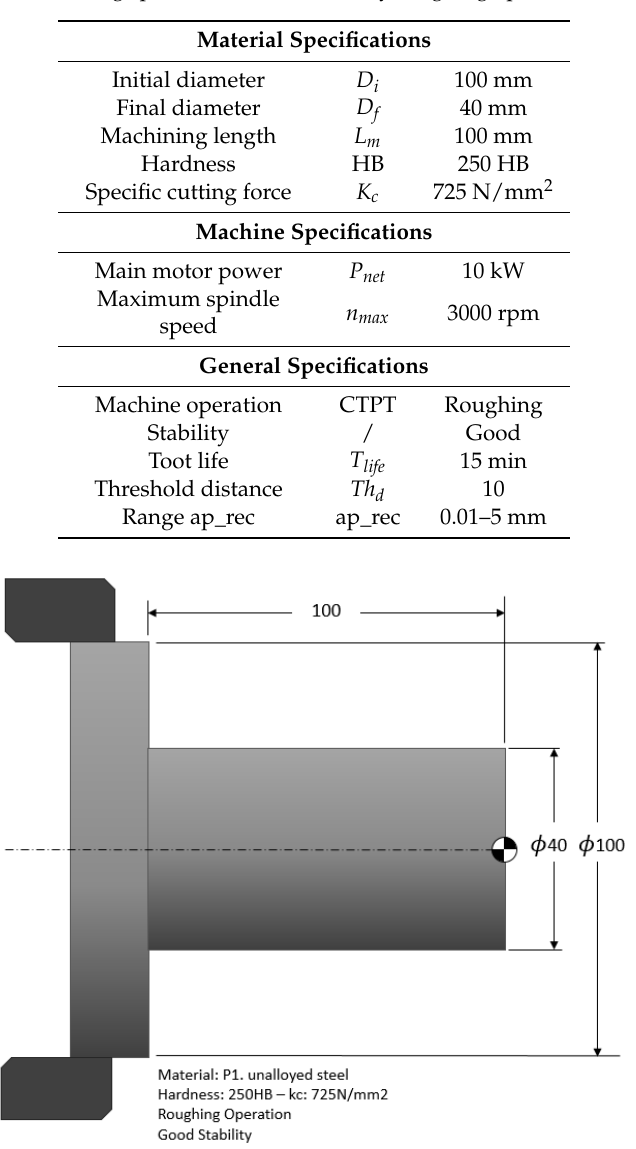
Table 13. Results of the heavy roughing operation example. Features